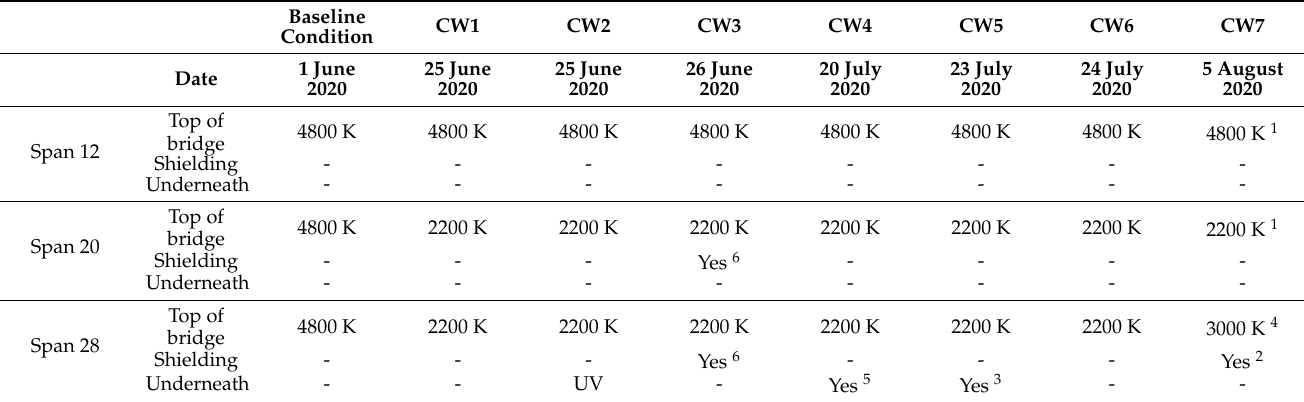
Table 1. Lighting characteristics on top and under the bridge at each span for seven trials (from CW1 to CW7) and the reference baseline condition.